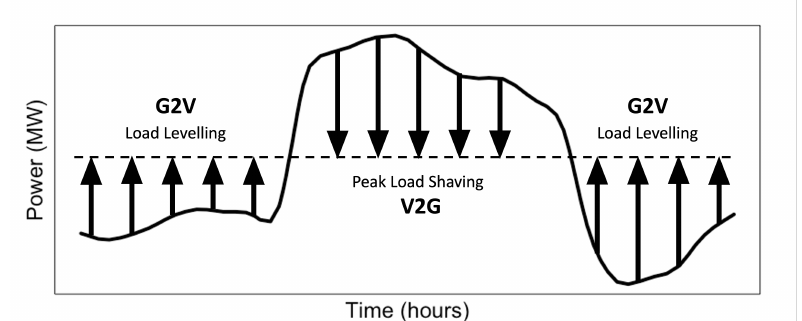
Figure 2. Peak-load shaving and load-levelling. Source: Redrawn from